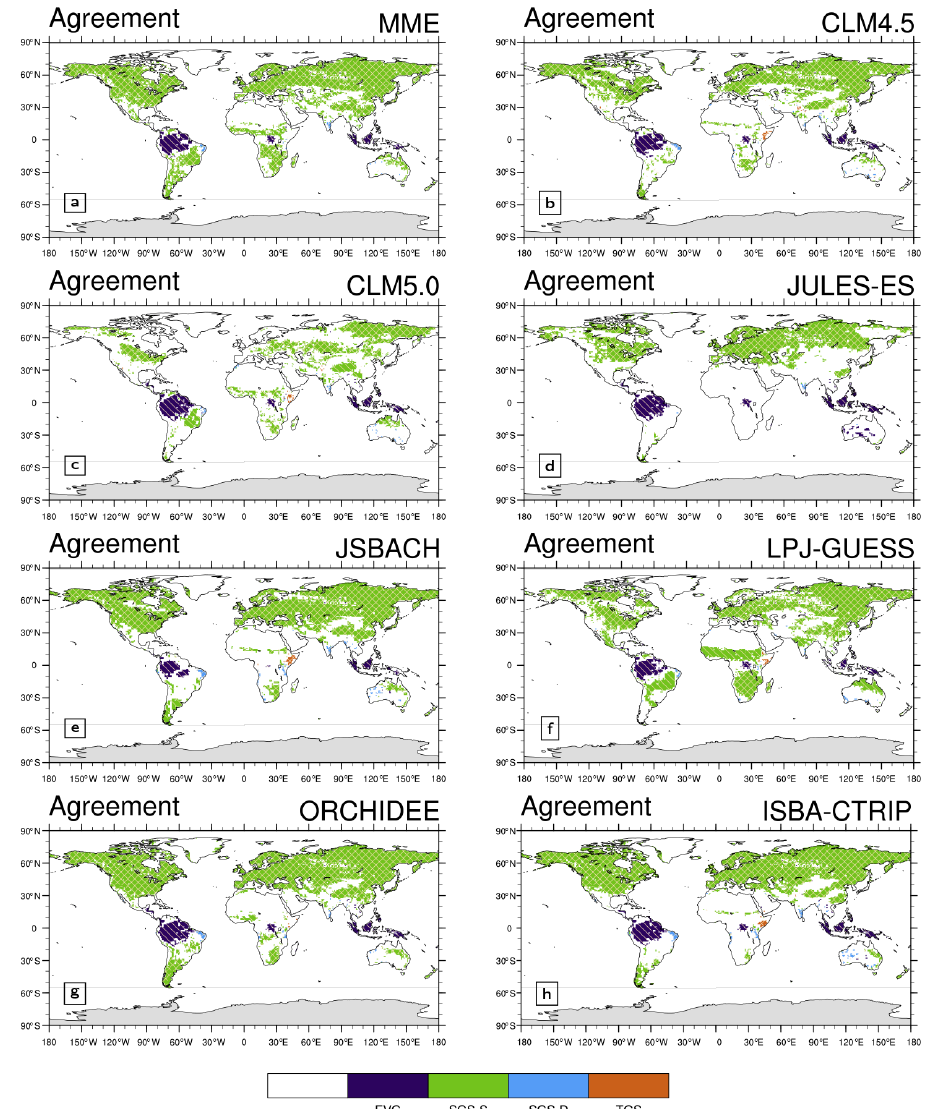
Figure 3. Global climatological (averaged over 2000–2011) distribution of the four main growing season modes for (a) MME, (b) CLM 4.5, (c) CLM 5.0, (d) JULES-ES, (e) JSBACH, (f) LPJ-GUESS, (g) ORCHIDEE, and (h) ISBA-CTRIP. The areas characterized by the same type of LSMs and MODIS (Fig. 2a) are coloured. These common areas are called agreement regions. Index values: (purple) evergreen, (green) single season with summer LAI peak, (cyan) single growing season with summer dormancy, and (orange) two growing seasons type. White regions are for disagreement areas. Above this selection, areas of agreement between satellite products are shaded with a different hatching pattern: MODIS and LAI3g (Fig. 2d) slash hatching ( / ); MODIS and CGLS (Fig. 2g) backslash hatching ( \ ); MODIS, CGLS, and LAI3g crossed hatching ( ×